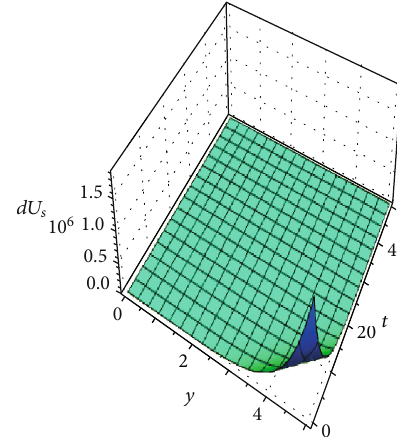
Figure 6: The applied magnetic fi eld B